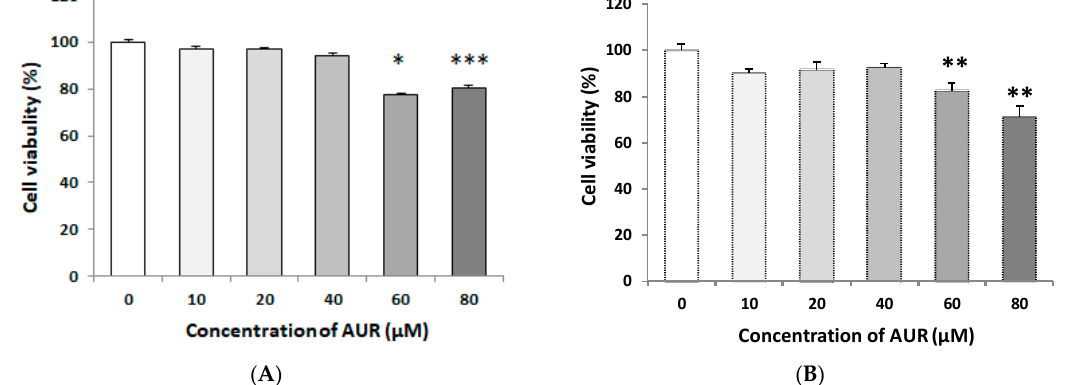
Figure 1. Effects of treatment with auraptene (AUR) on C6 cell viability in medium containing 10% fetal bovine serum (FBS) ( A ) or 2% FBS ( B ). Cells were treated with various concentrations (0–80 µ M) of AUR for 24 h. The results are presented as the mean ± SEM ( n = 4). Significance difference in values between the non-treated (0 µ M) and AUR-treated cells: * p < 0.05; ** p < 0.01; *** p < 0.001.